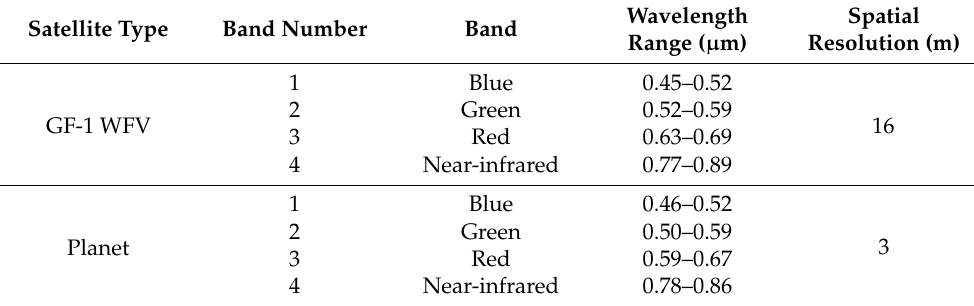
Table 1. The parameters of the satellite data used in this paper.